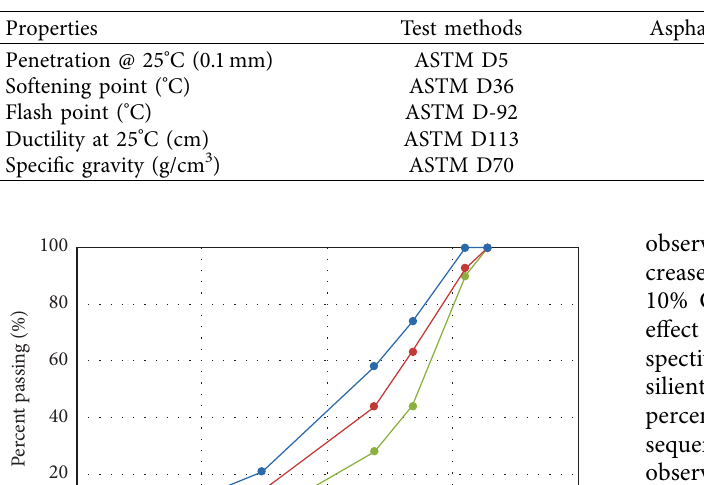
Table 1: Asphalt binder, VB, and Cyclogen properties.